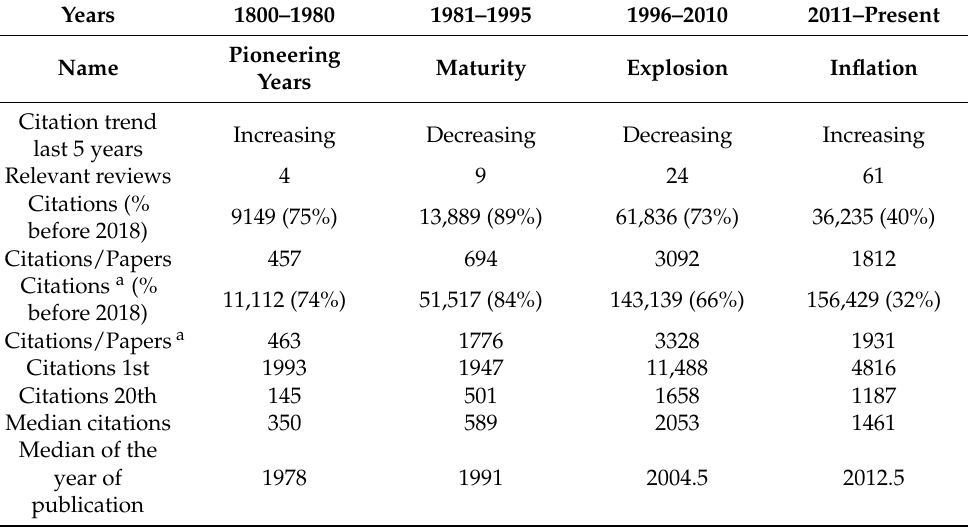
Table 1. Overview of the main bibliometric indexes regarding “photocatalysis” divided into the four temporal